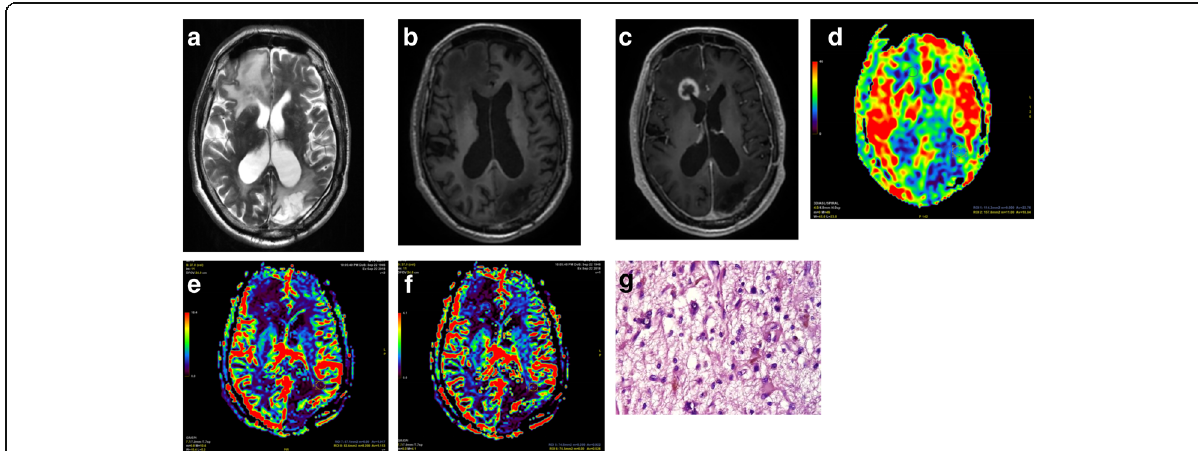
Fig. 1 MR perfusion in a case with the right periventricular low-grade glioma. a Axial T2WI showing right frontal periventricular slightly hypointense lesion surrounded by vasogenic edema. b , c Pre- and post contrast T1WI showing isointense signal with hypointense edema with manifest post contrast enhancement of the periventricular lesion. d ASL-CBF showing iso to hypoperfusion of the lesion with ASL-rCBF of 0.72. e , f DSC-CBF and CBV showing hypoperfusion with DSC-rCBF of 0.47 and DSC-rCBV of 0.62. g Hematoxylin and eosin staining (×400 magnification) showing moderate cellularity and moderate nuclear enlargement and pleomorphism with few vessels, pathologically proven low-grade NOS WHO grade II glioma with ASL matching with DSC in showing hypoperfusion of the lesion. ASL arterial spin labeling, CBF cerebral blood flow, DSC dynamic susceptibility contrast, CBV cerebral blood volume, NOS not otherwise specified, r relative, WI weighted imaging